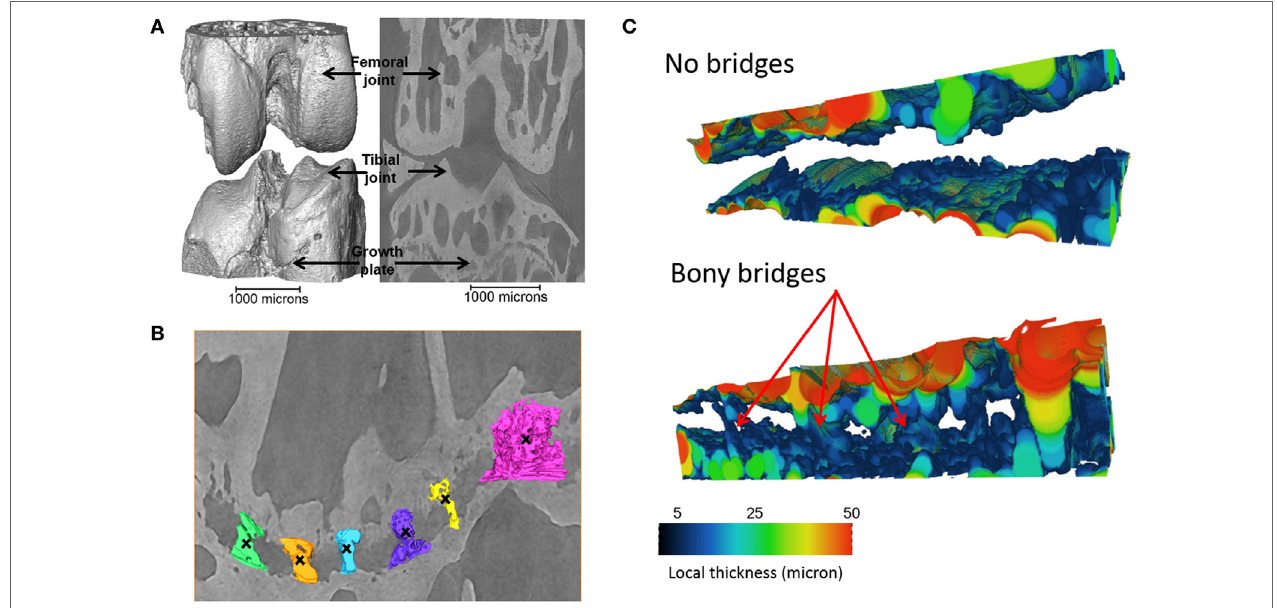
FigUre 1 | Identification of the bridges crossing the growth plate (a) 3D representation of the whole joint, (B) bridges crossing the growth plate, in an ROI (black crosses indicate bony bridges identified by an observer). (c) 3D representation of the growth plate with no bridges and multiple bridges observed. Adapted from Staines et al.